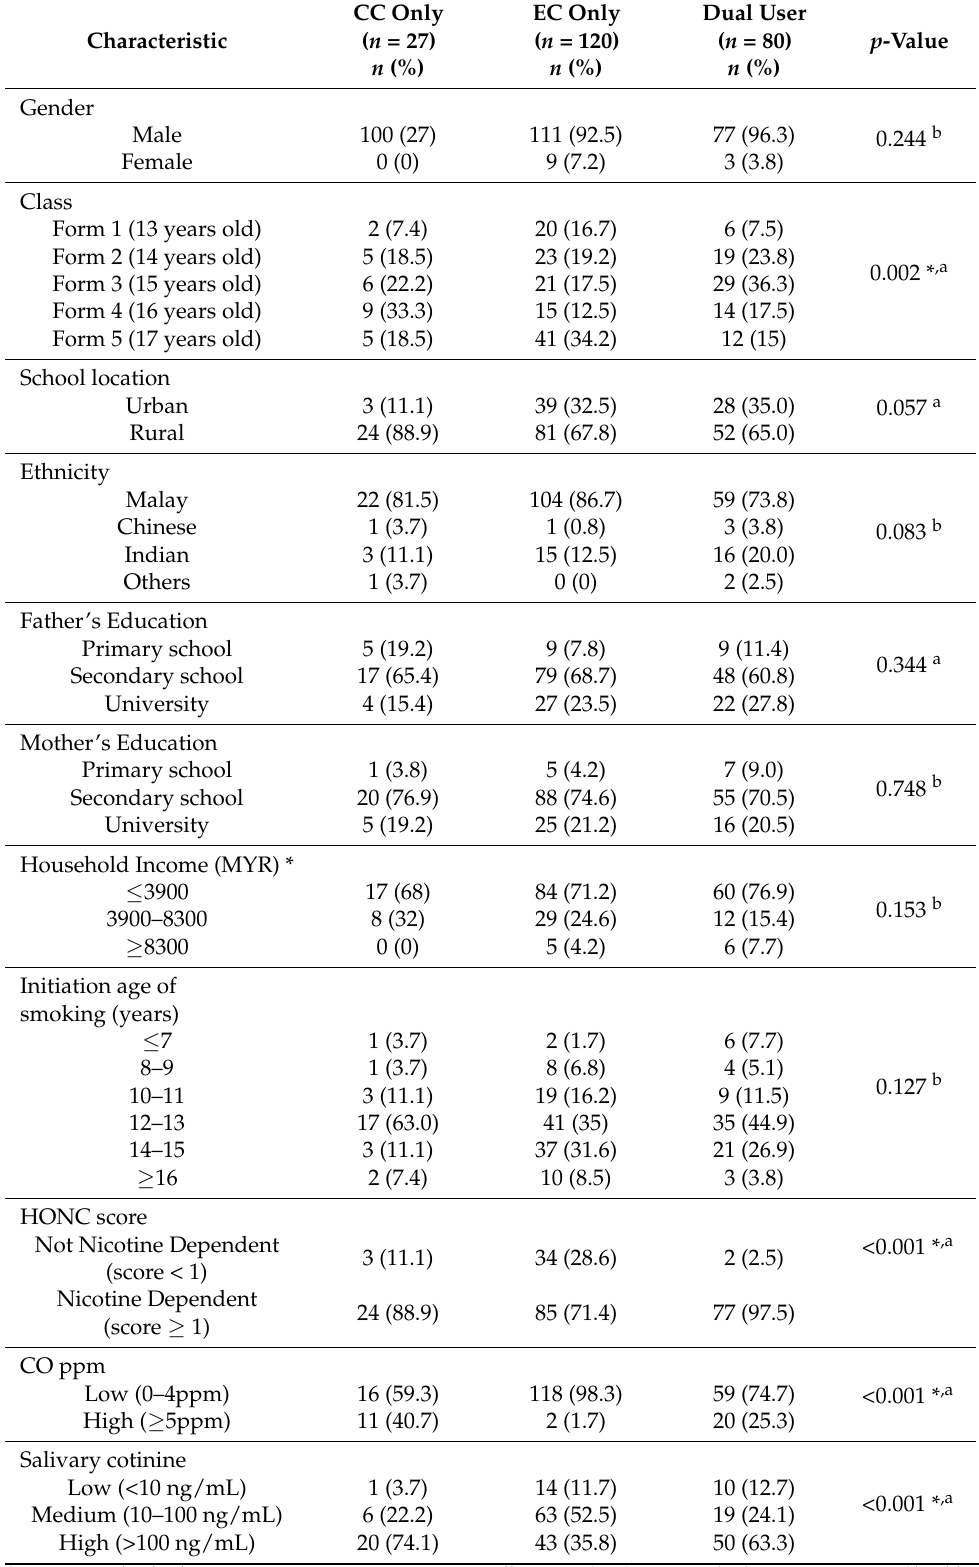
Table 2. Association between sociodemographic characteristics and types of cigarette user ( N = 227).